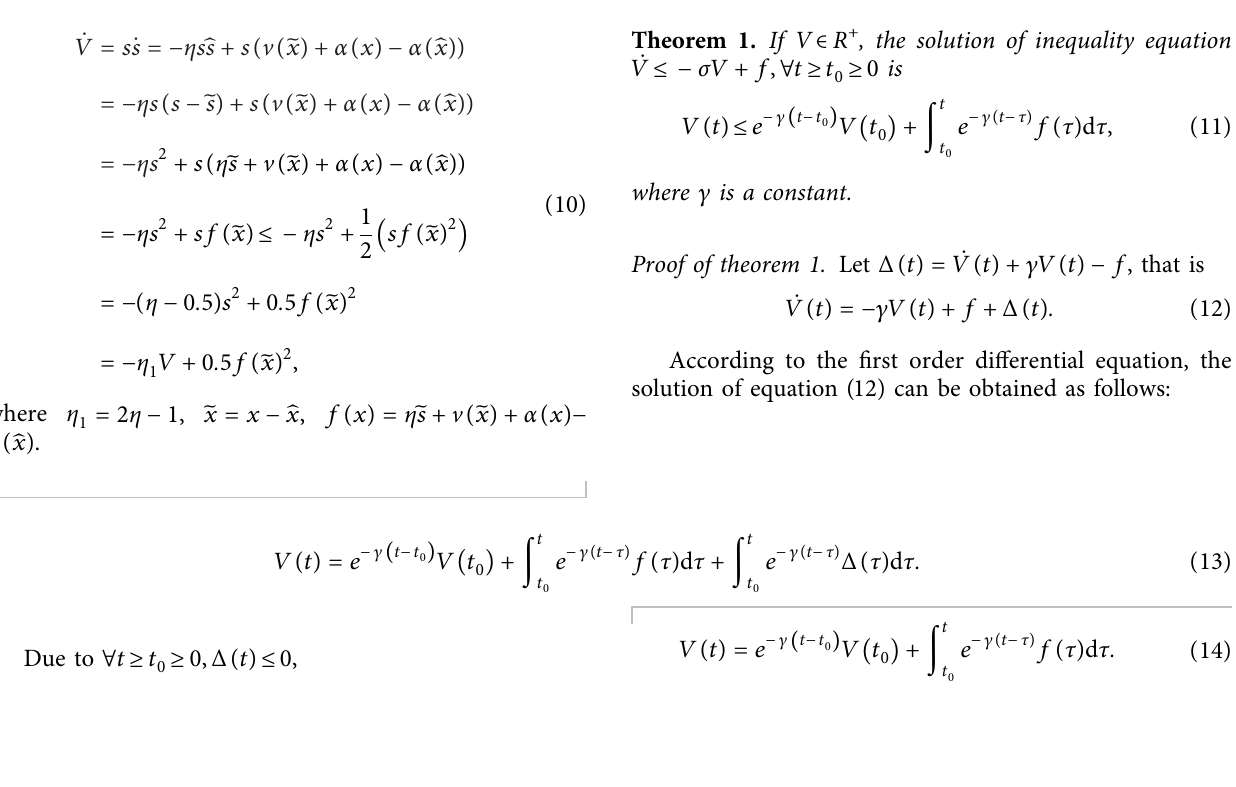
Figure 5: Control inputs of sinusoidal